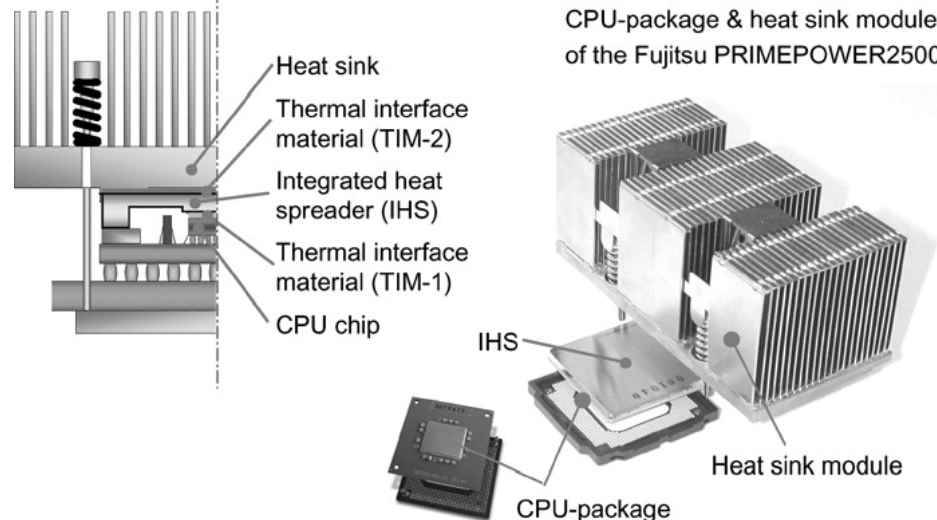
Figure 1. A typical structure of the CPU package and heat sink module [21].